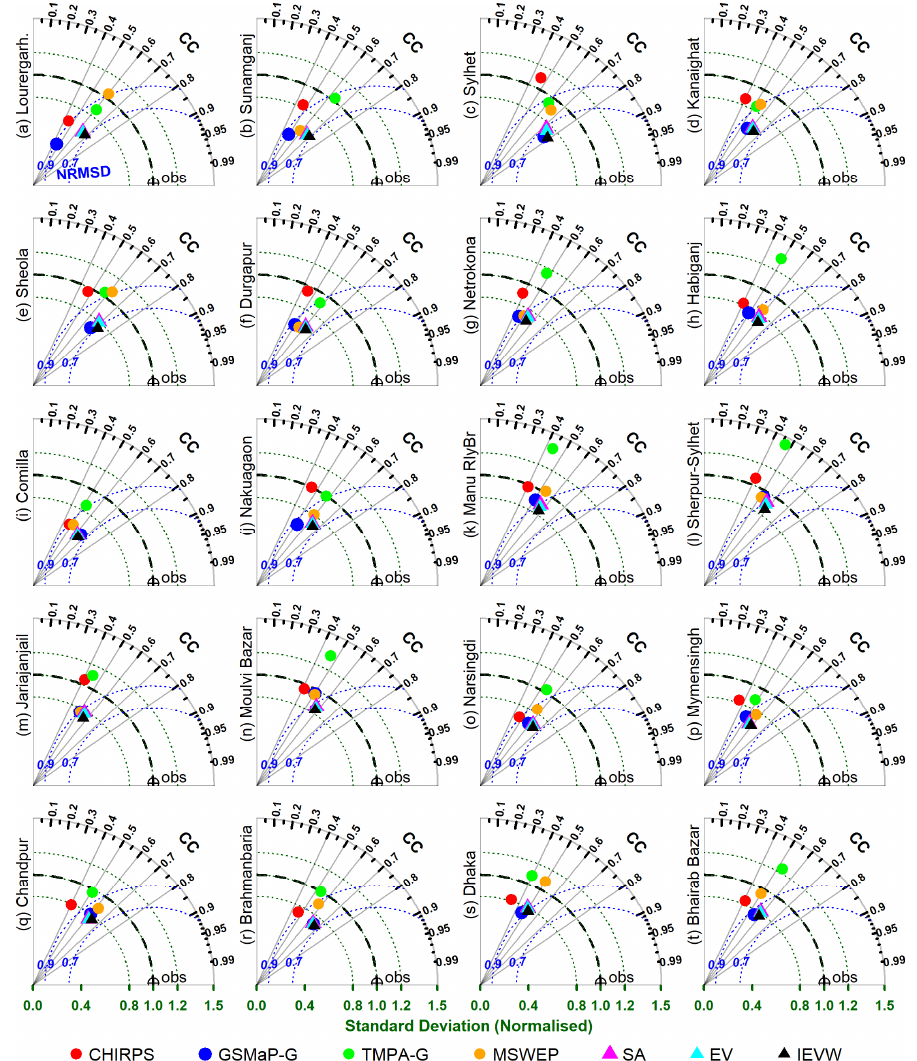
Figure 9. Taylor diagram illustrating a statistical comparison between satellite products (original and merged) and ground rainfall (obs mark) for the wet seasons of 2009–2016 at 20 rain-gauge stations ( a – t ). Instructions for reading a Taylor diagram are given in Figure 8.